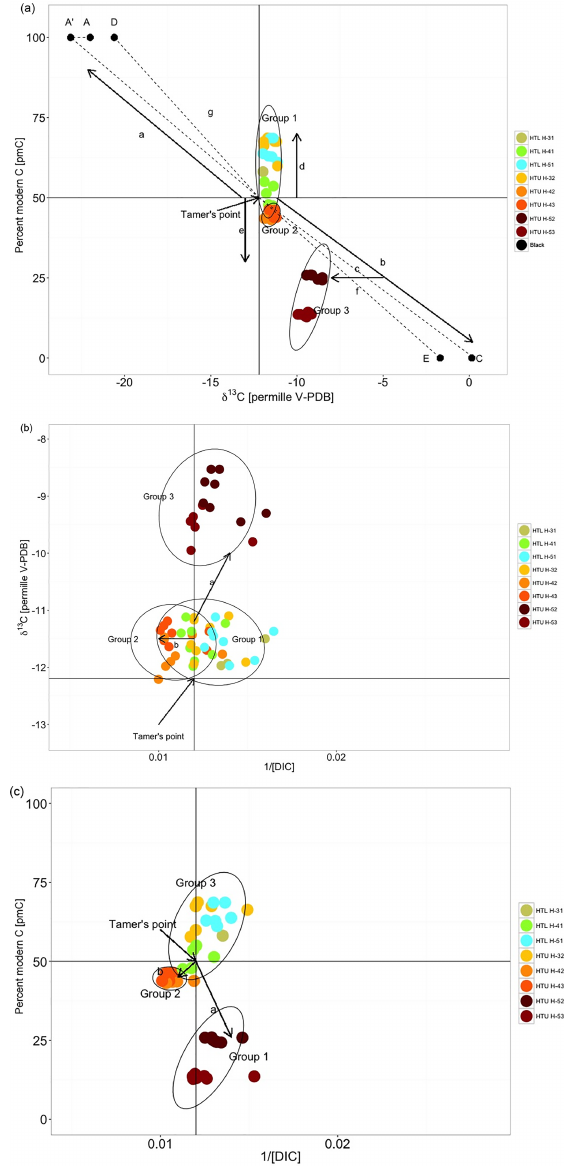
Figure 6. (a) Han–Plummer plot with data from groundwater sam- pling wells. The Methods section describes in detail the theory behind these plots and identifies the various elements shown in the figure. By plotting 14 C vs. δ 13 C three different groups can be distinguished. The oxic wells of HTL including well H-32 form Group 1, wells H-42 and H-43 (Group 2), as well as H-52 and H-53 (Group 3). The Han–Plummer plot indicates 14 C enrichment due to bomb carbon for Group 1 wells (arrow d), oxidation of 14 C- depleted OM accompanied with calcite dissolution in Group 2 wells (arrow e), and complex water–rock interactions and OM turnover in Group 3 wells (arrow c). Further explanations are given in the text. (b) Plotting 13 C vs. 1 / DIC (mmolL − 1 ) also allows distinguish- ing of the three groups. Group 2 is not distinct in 14 C compared to Group 1, but differs in DIC concentration. Group 2 is distinct from Group 1 in δ 13 C, but does not differ in DIC concentration. (c) Plot- ting δ 13 C concentrations against 1 /